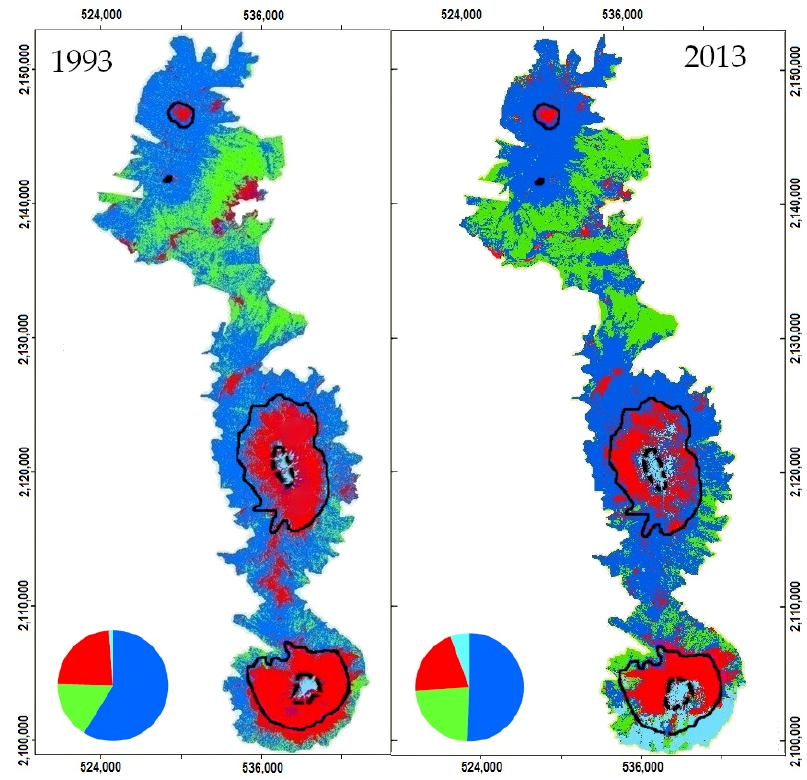
Figure 2. The 1993 ( left ) and 2013 ( right ) Izta-Popo’s RSD classified maps, with indication of the percentage distribution of each class (cheese diagram). Blue : Clouds. Red : Pastures and croplands. Dark blue : Pine forest ( Pinus hartweggii-Muhlenbergia macrorura ). Green : Pino-Encino-Oyamel mixed forest ( Pinus patula-Quercus crassipes ; Pinus patula-Quercus laurina ; Abies religiosa ). Continuous line: 4000 m a.s.l.; dotted line: 4800 m a.s.l.